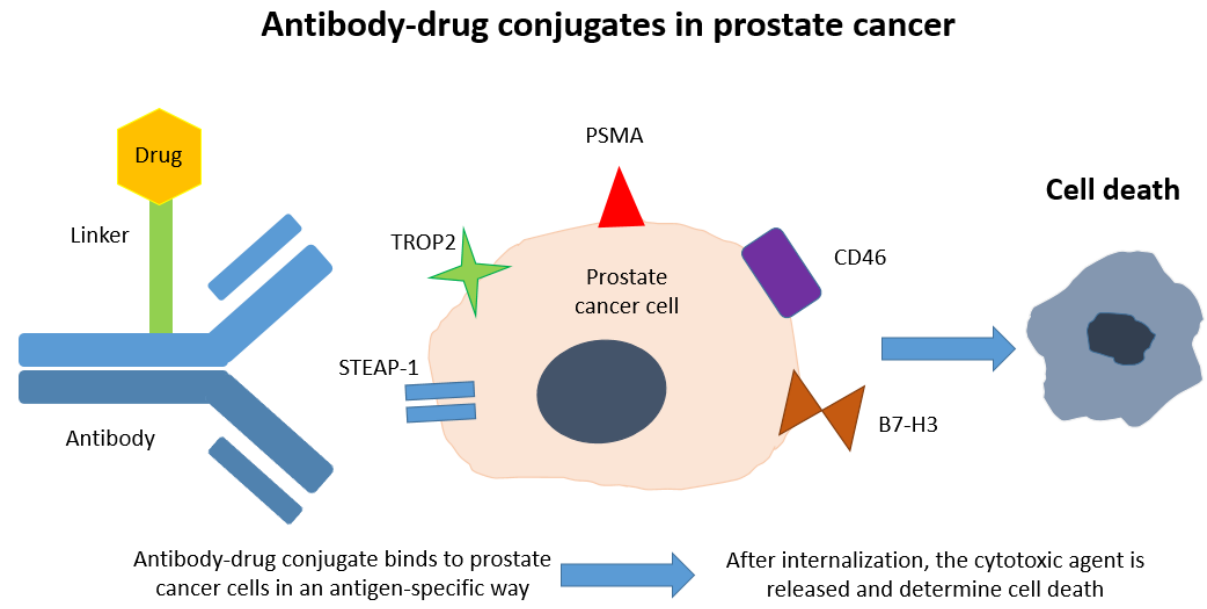
Figure 1. Cartoon representing the mechanism of action of ADCs in prostate